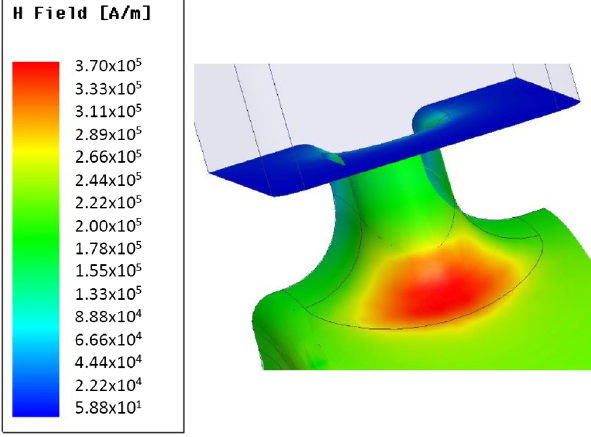
FIG. 3. H field in the coupler region corresponding to a 120 MV = m cathode peak field.